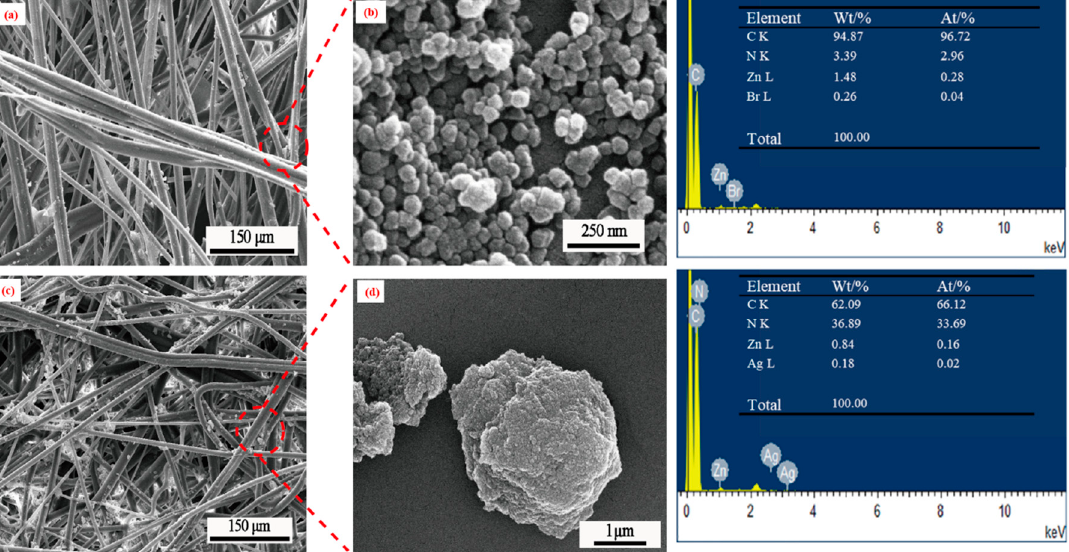
Figure 5. SEM and EDS analyses of ZIF-8@ melt-blown nonwoven fabrics and Ag@ZIF-8@ melt-blown nonwoven fabrics. ( a ) ZIF-8@melt-blown nonwoven fabrics ( c ) Ag@ZIF-8 melt blown nonwoven fabric ( b , d ) are the magnify of ZIF-8 and Ag@ZIF-8 nanoparticle on non-woven fabric, respectively3.4. FTIR Analysis.